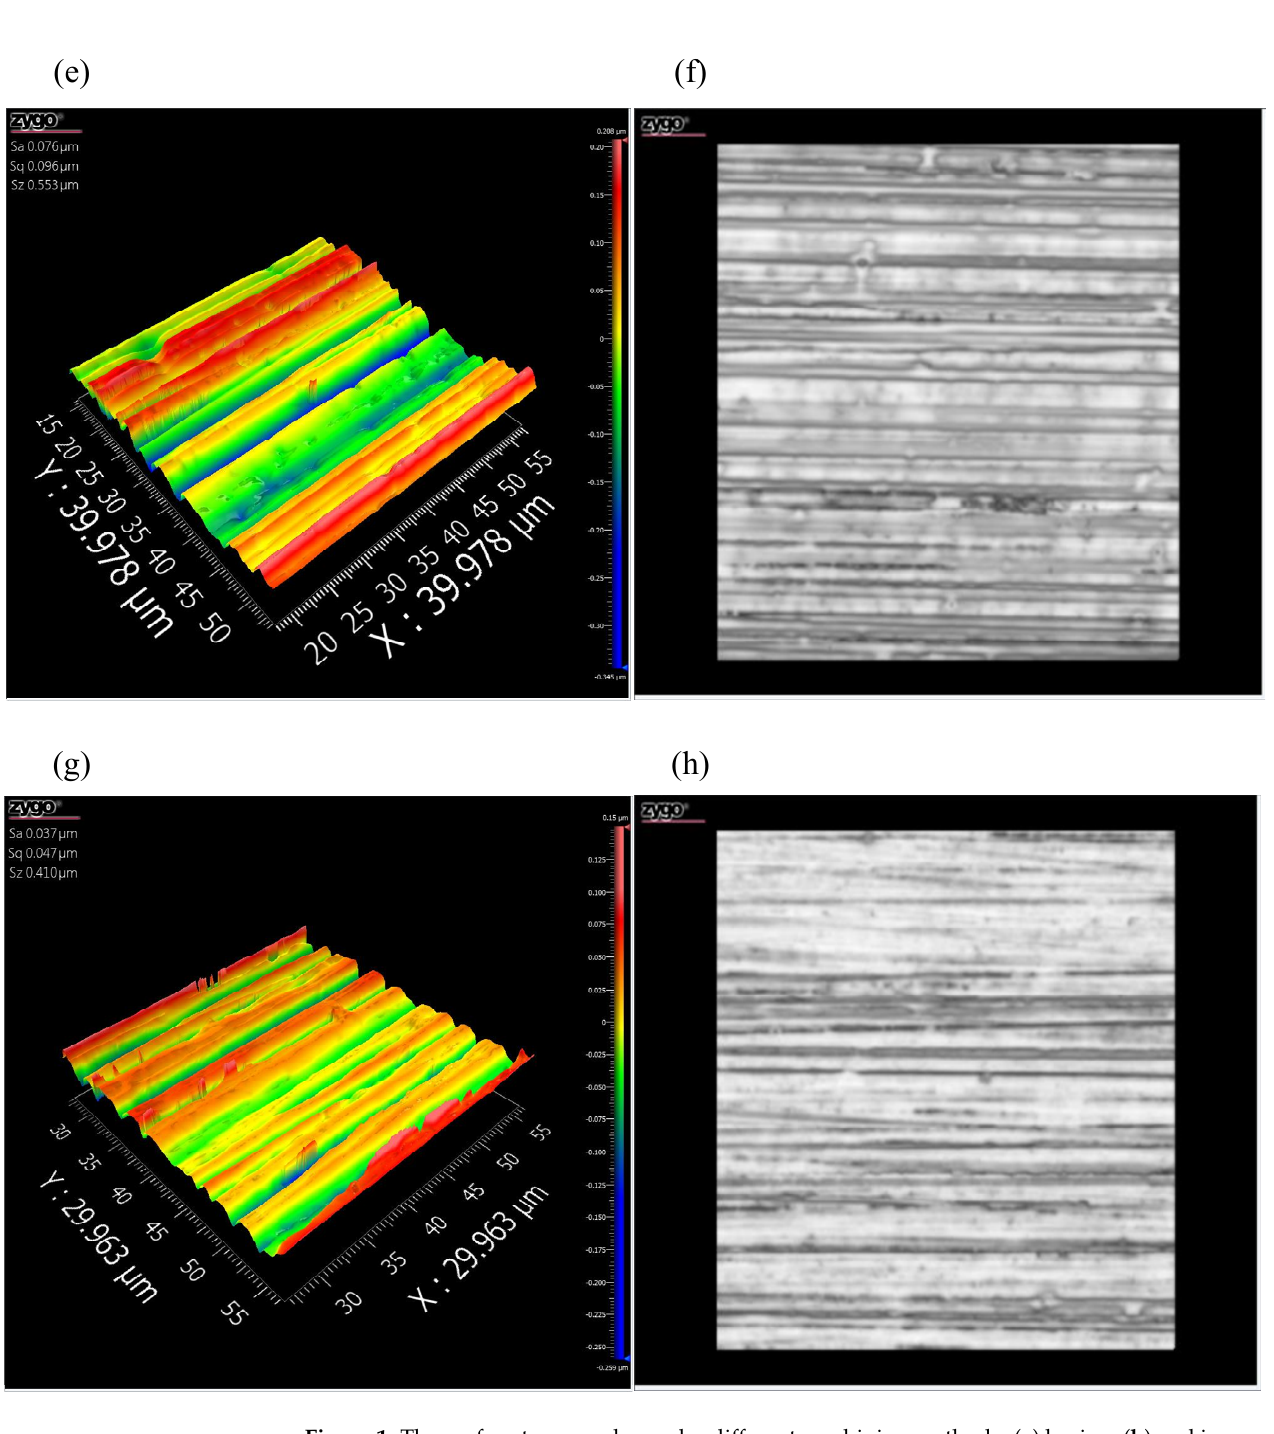
Figure 1. The surface topography under different machining methods: ( a ) boring; ( b ) real image of boring; ( c ) turning; ( d ) real image of turning; ( e ) smooth grinding; ( f ) real image of smooth grinding; ( g ) grinding; ( h ) real image of grinding.